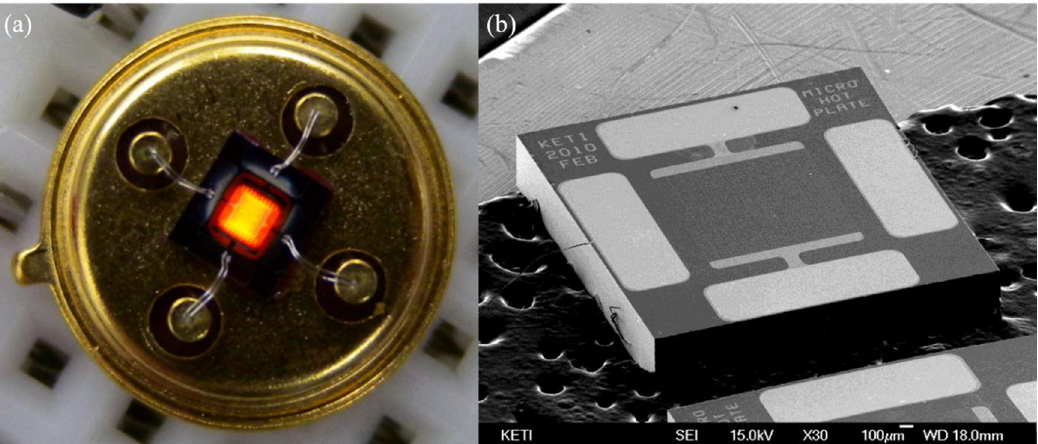
Figure 13. Schematic diagram of external micro-heater. Reprinted from [143]. ( a ) Packaged the micro-heater using TO39 package; ( b ) the SEM image of the micro-heater.